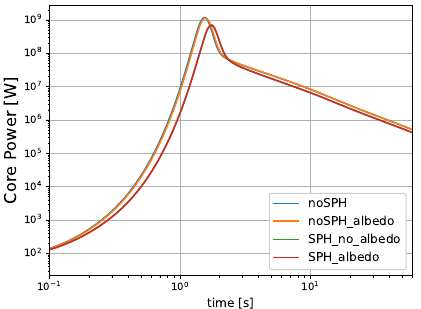
Figure 5: Reactor power with and without the albedo boundary